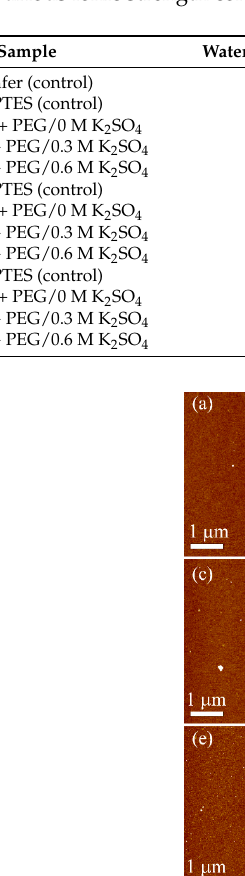
Table 2. Water contact angles and surface roughness values for APTES and PEG grafted silicon wafer surface under various ionic strength conditions at 60 ◦ C.